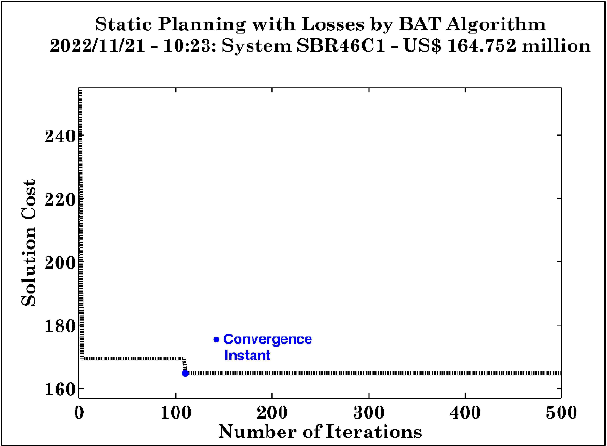
Figure 18: Case WOR - SB-46/79 t est system. Cost convergence curve, Source: BATp optimizer, (2022).